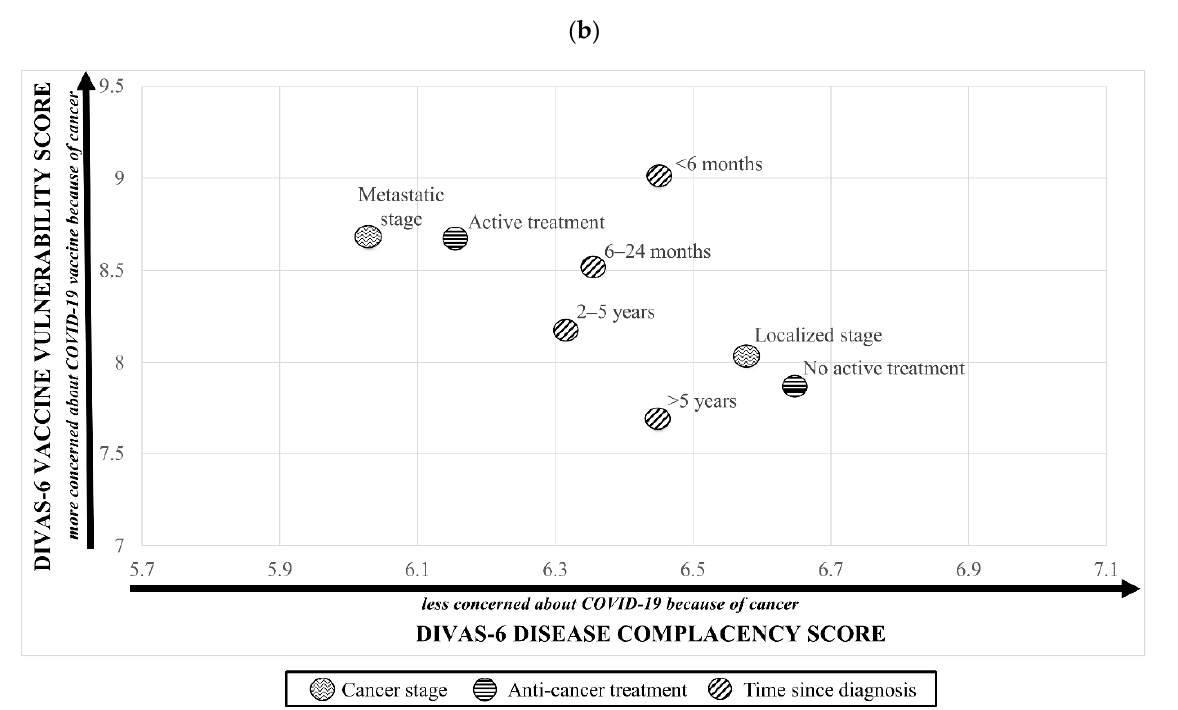
Figure 4. DIVAS-6 Disease Complacency against Vaccine Vulnerability scores by ( a ) cancer type ( b ) clinical characteristics. * indicates whether the cancer type, when compared with all other cancer types, was significant when individually regressed with both the DIVAS-6 Disease Complacency and DIVAS-6 Vaccine Vulnerability subscales’ scores. Note: Brain cancer was the most common cancer type reported within the ‘other’ cancers category (n = 46) and was included instead of the whole category. Abbreviations: DIVAS-6, Disease Influenced Vaccine Acceptance Scale-6. (please see Figure S4a and b for clearer figure)